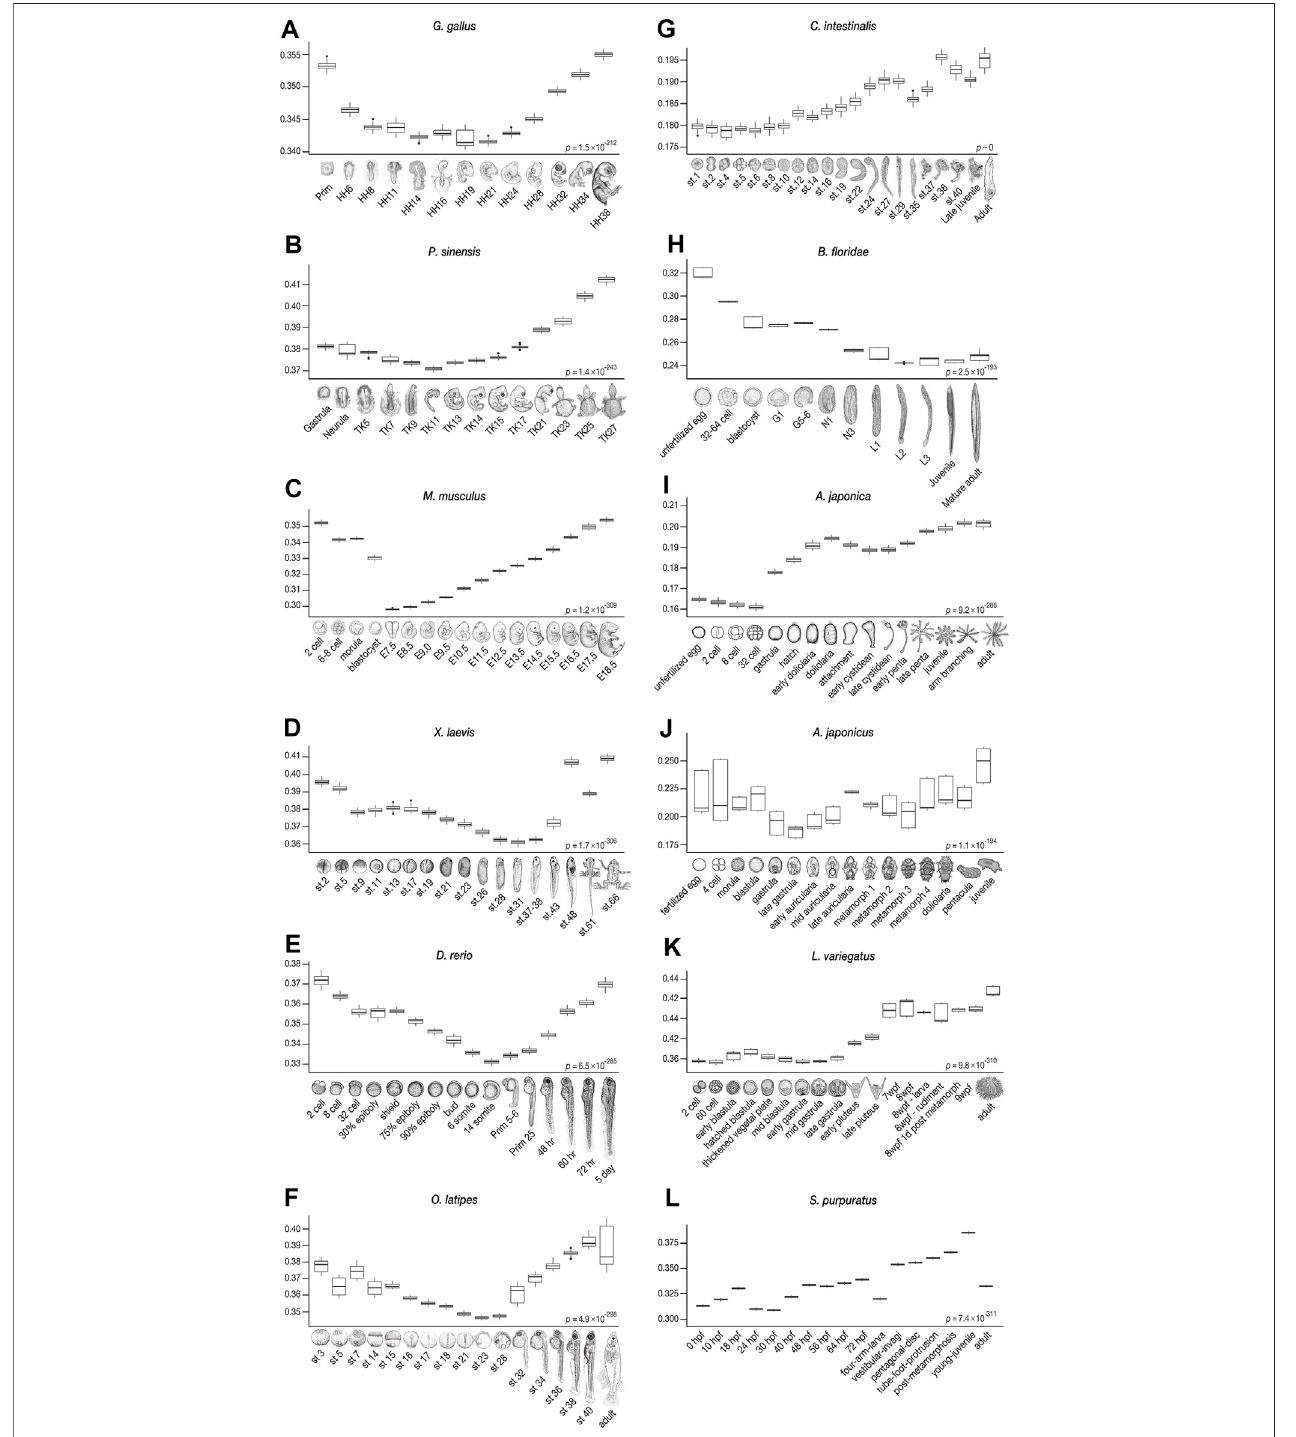
FIGURE4| Derivednessindexofembryosofchordatesandechinodermsestimatedfromtheirrespectivecommonancestors.Therangeofderivedness indicesof eachembryo,fromthecommonancestorofchordatesandechinoderms,respectively,in100biologicalreplicates-included(BRI)trees. (A – F) Theleastderivedstagesin vertebratespecies( Gg , Ps , Mm , Xl , Dr ,and Ol )aremid-embryonicandorganogenesisstages( Gg :HH14-19, Ps :TK11, Mm :E7.5*, Xl :stage31, Dr :14-somites,and Ol : stage 23). *: E9.5, in mouse when the Quartz-Seq samples were removed (see Figures 6B – 6ii ). (G – H) The tunicate C. intestinalis shows relatively lower derivedness indices in stage 1 to stage 10 embryos, and the least derived stage in the amphioxus B. fl oridae is around the L2 (open-mouth larva) stage. (I – L) In echinoderm species, the least derived stage is around the gastrula in sea cucumber and sea urchins, whereas the 32-cell stage is the least derived in feather star. (Differences in derivedness index for each developmental stage are statistically signi fi cant; Friedman test).